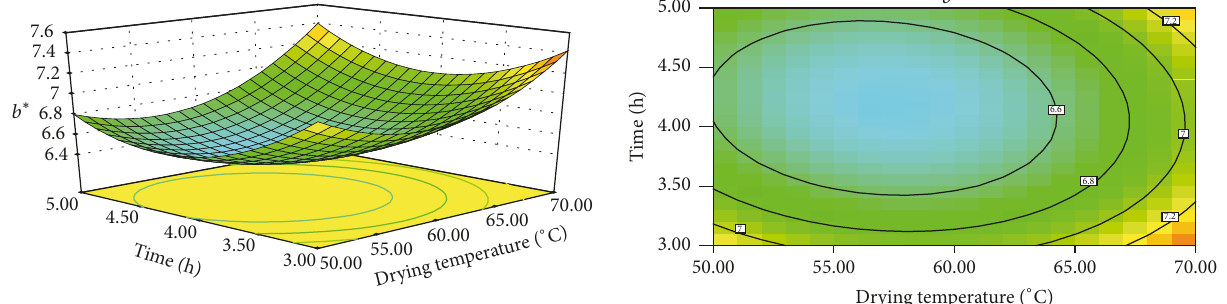
Figure 4: 3D response surface and contour plots for the effect of drying temperature and time on 𝑏 ∗ value of